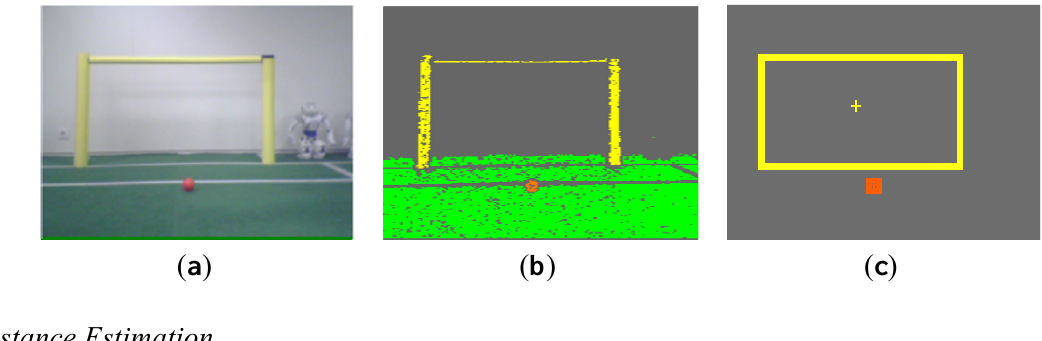
Figure 7. Results from image acquisition and processing: ( a ) Original picture; ( b ) Segmented image; ( c ) Bounding boxes of the goal and ball.